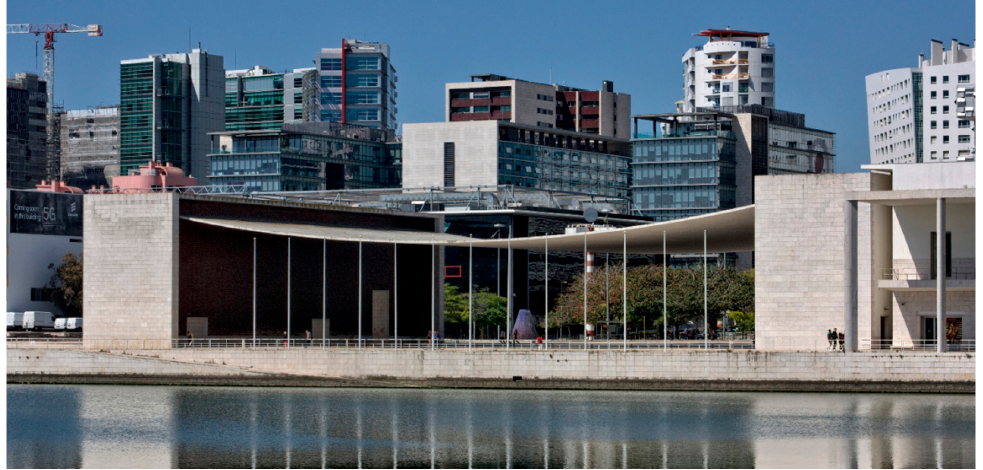
Figure 1. Portugal Pavilion for Expo Lisbon ‘98—architect Alvaro Siza.